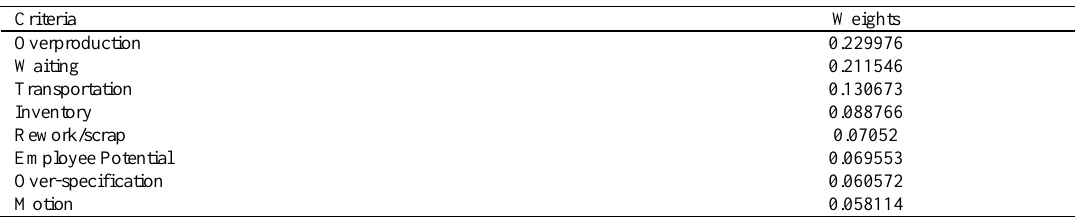
Table 5. Defuzzified criteria